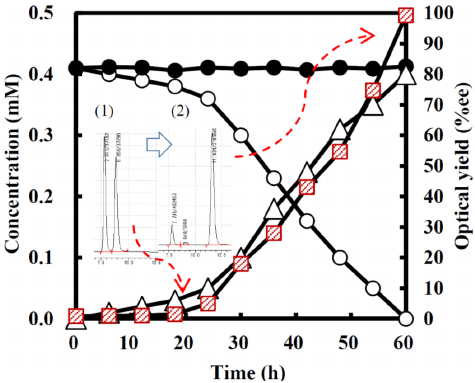
Figure 2. Time course of the asymmetric oxidation activity (- ˝ -: % ee ) using expressed HasApf (40 µ M) and substrate rac - 1 (0.8 mM) in deionized water as a solvent (5.0 mL); the absorbances of ( S )- 1 (- -: 0.4 mM), ( R )- 1